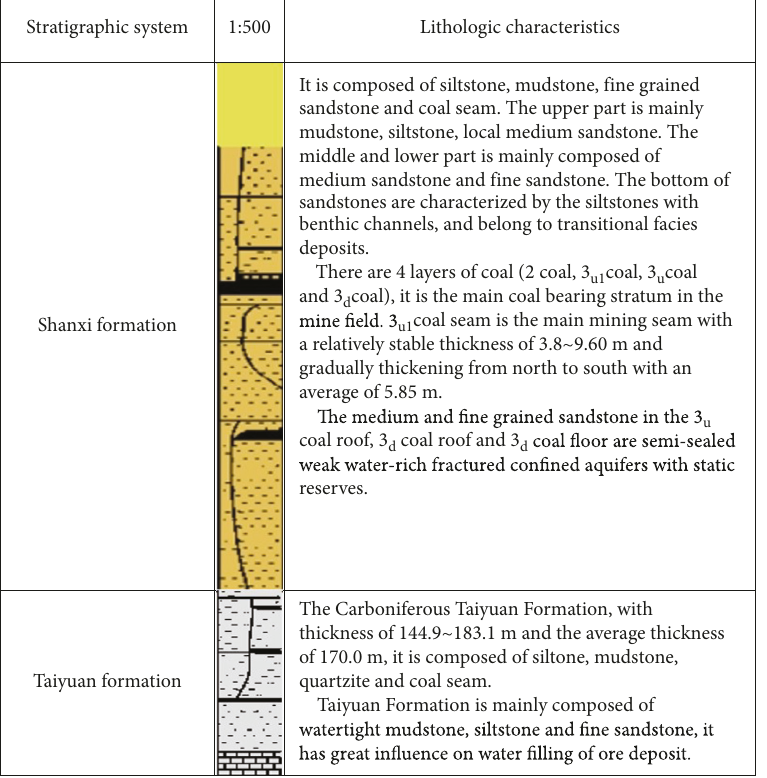
Figure 2: Stratograph.